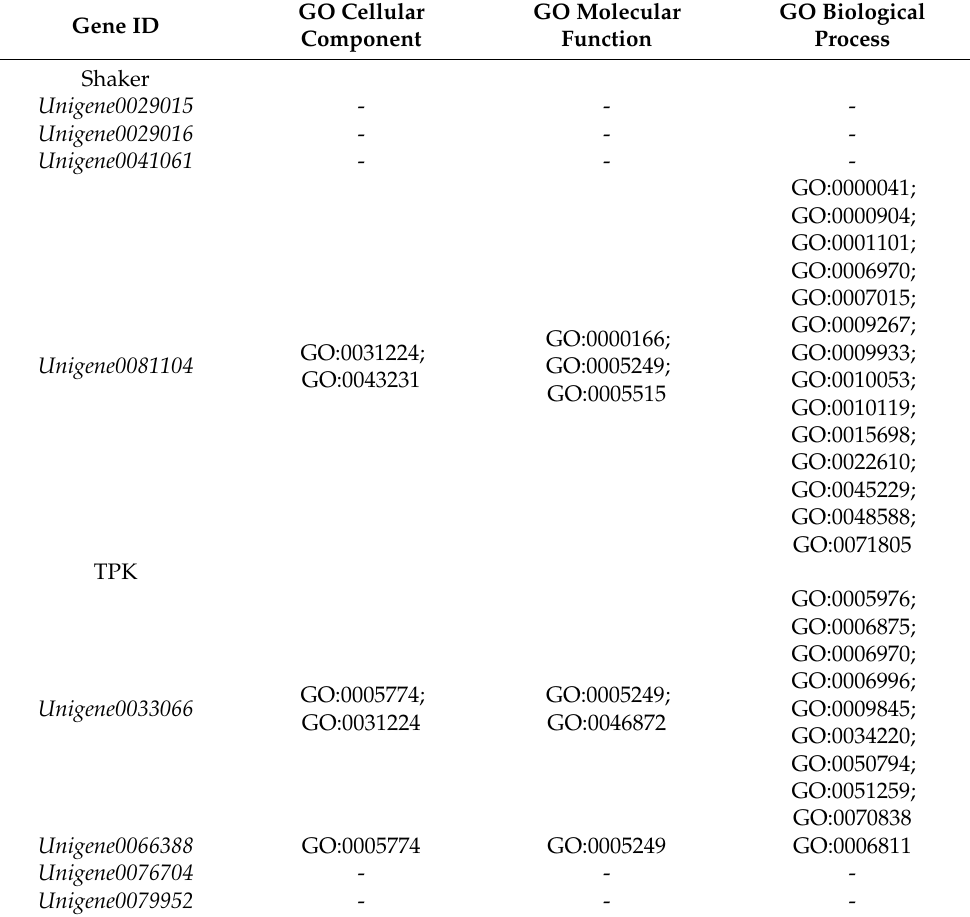
Table 3. GO enrichment of K + channel- and transporter-related